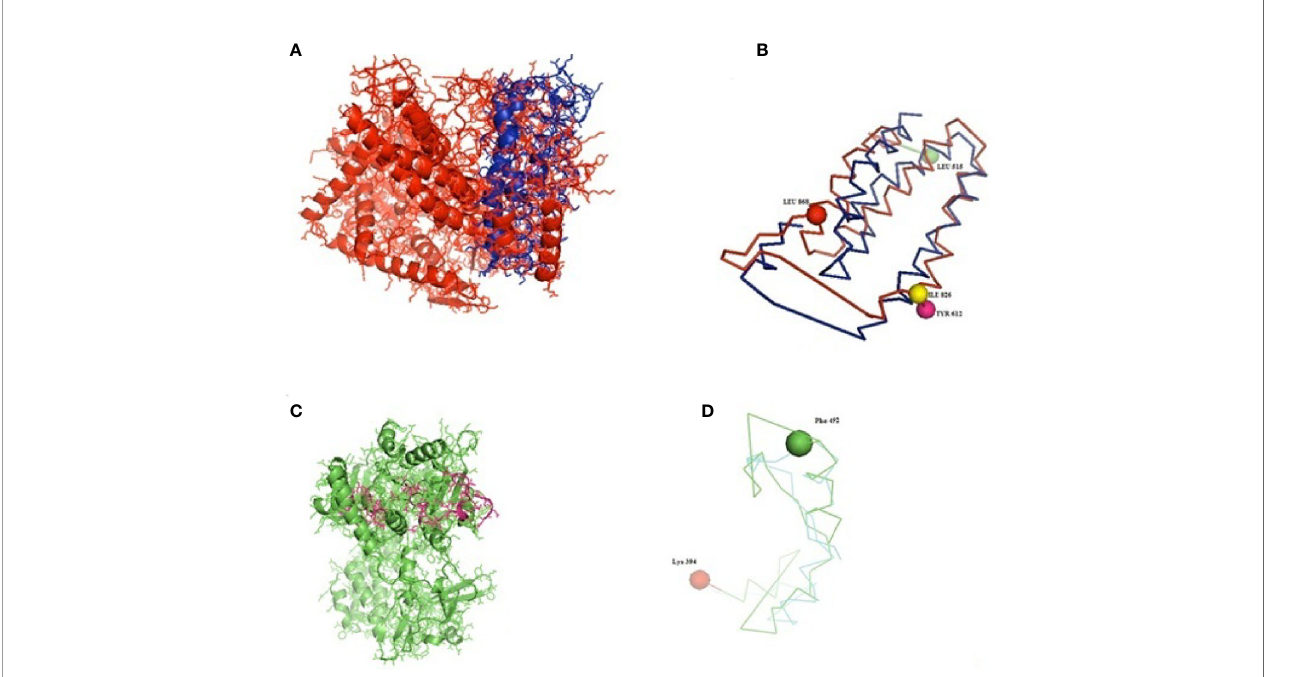
FIGURE 5 | (A – D) Molecular docking of parasitic protein nd 4 with ovine RIG-I, alignment (left) and binding site